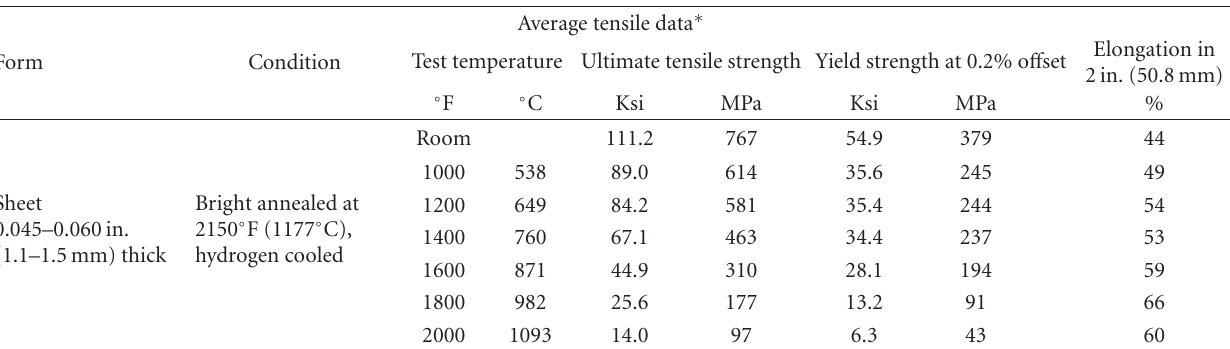
Figure 12: Stress contour in case of imposing contact condition. Table 3: Mechanical properties of Hastelloy-X